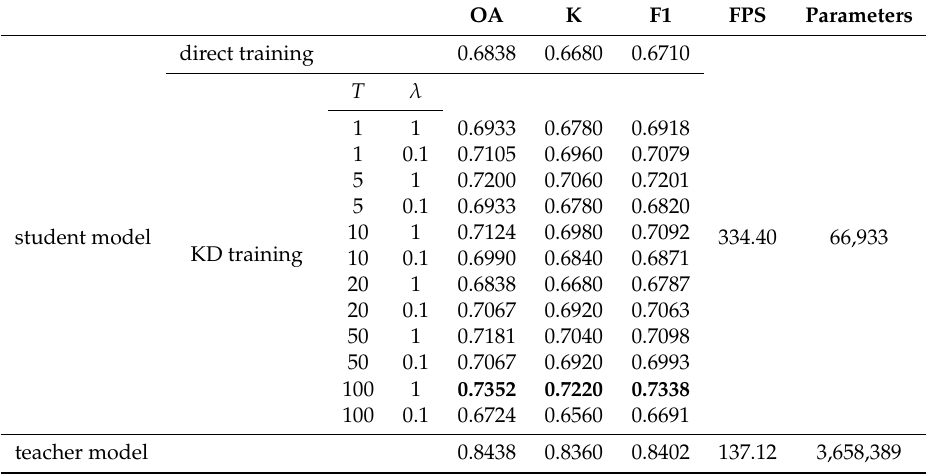
Table 7. Results of Knowledge Distillation training experiments on UCMerced